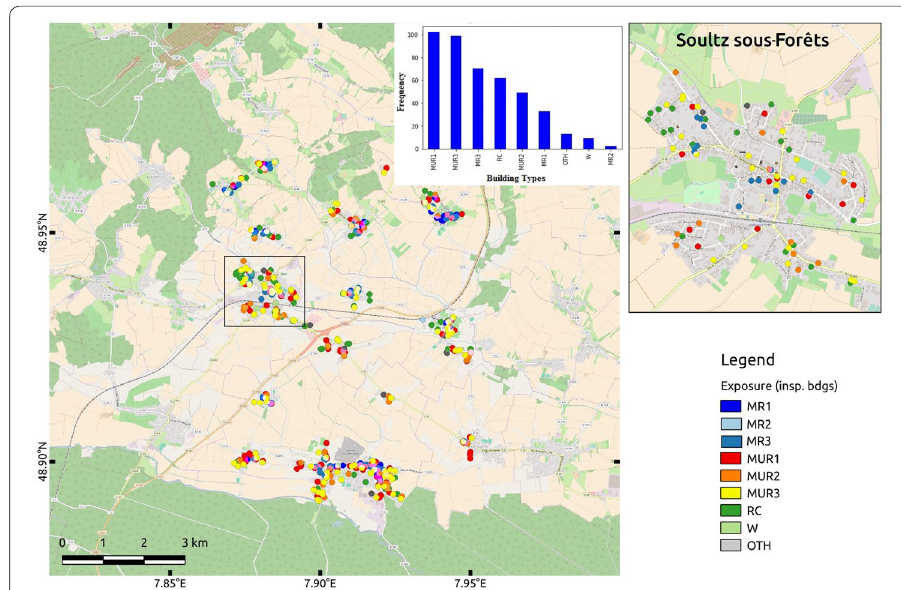
Fig. 3 Exposure model including 500 buildings’ assessment with remote rapid visual scanning in the Alsace region in France (MUR unreinforced masonry, MR = W wood, OTH other, 1 one-story building, 2 = = = building with flexible diaphragm)